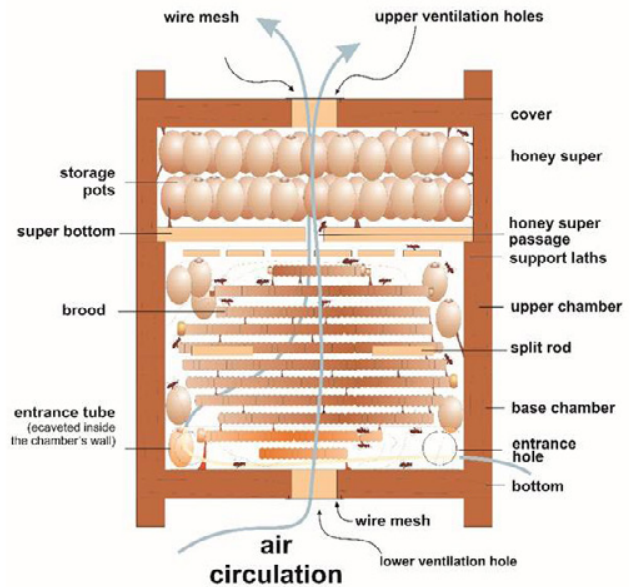
Fig 1 .Vertical (Embrapa) hive model developed for housing Scaptotrigona aff. postica